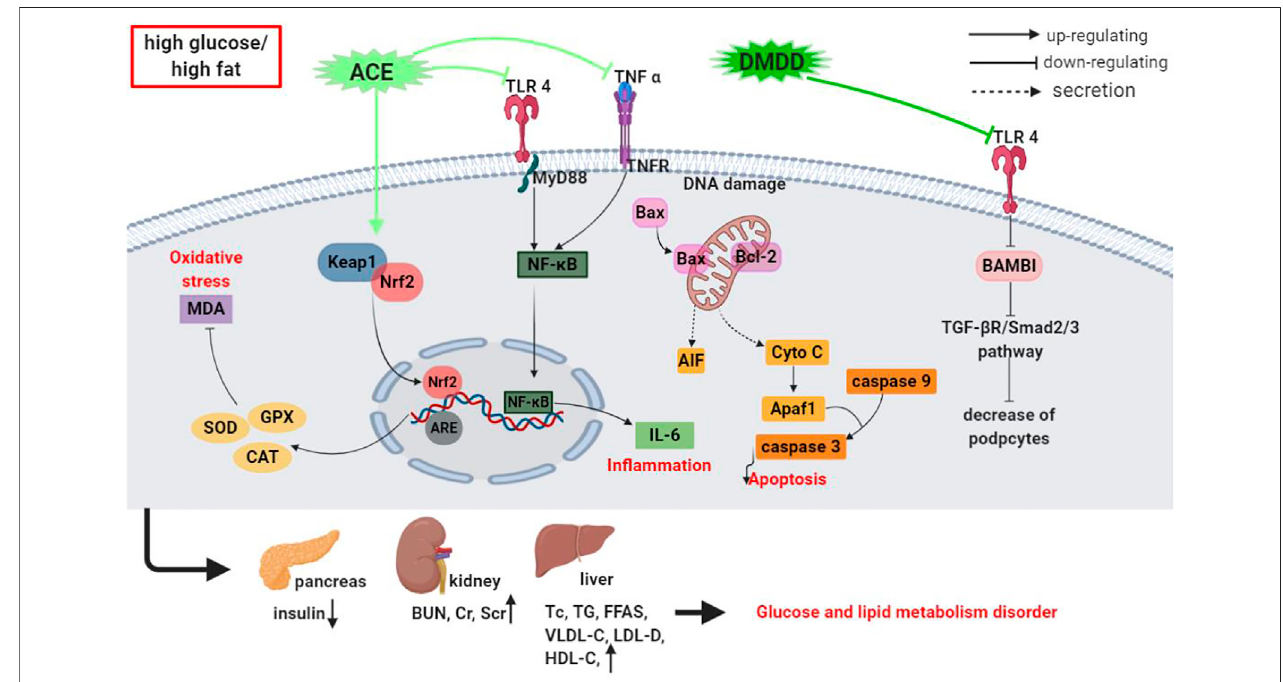
FIGURE 4 | Schematic representation of the underlying mechanism of anti-hyperglycemic activity of crude extracts or isolated compounds from A. carambola .